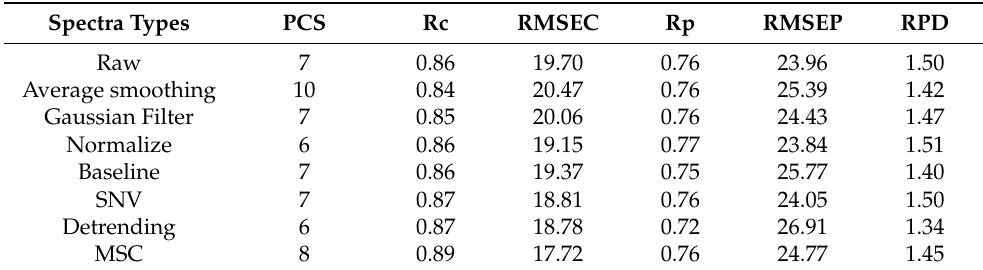
Table 2. Comparative analysis of PLSR models with different pretreatments.